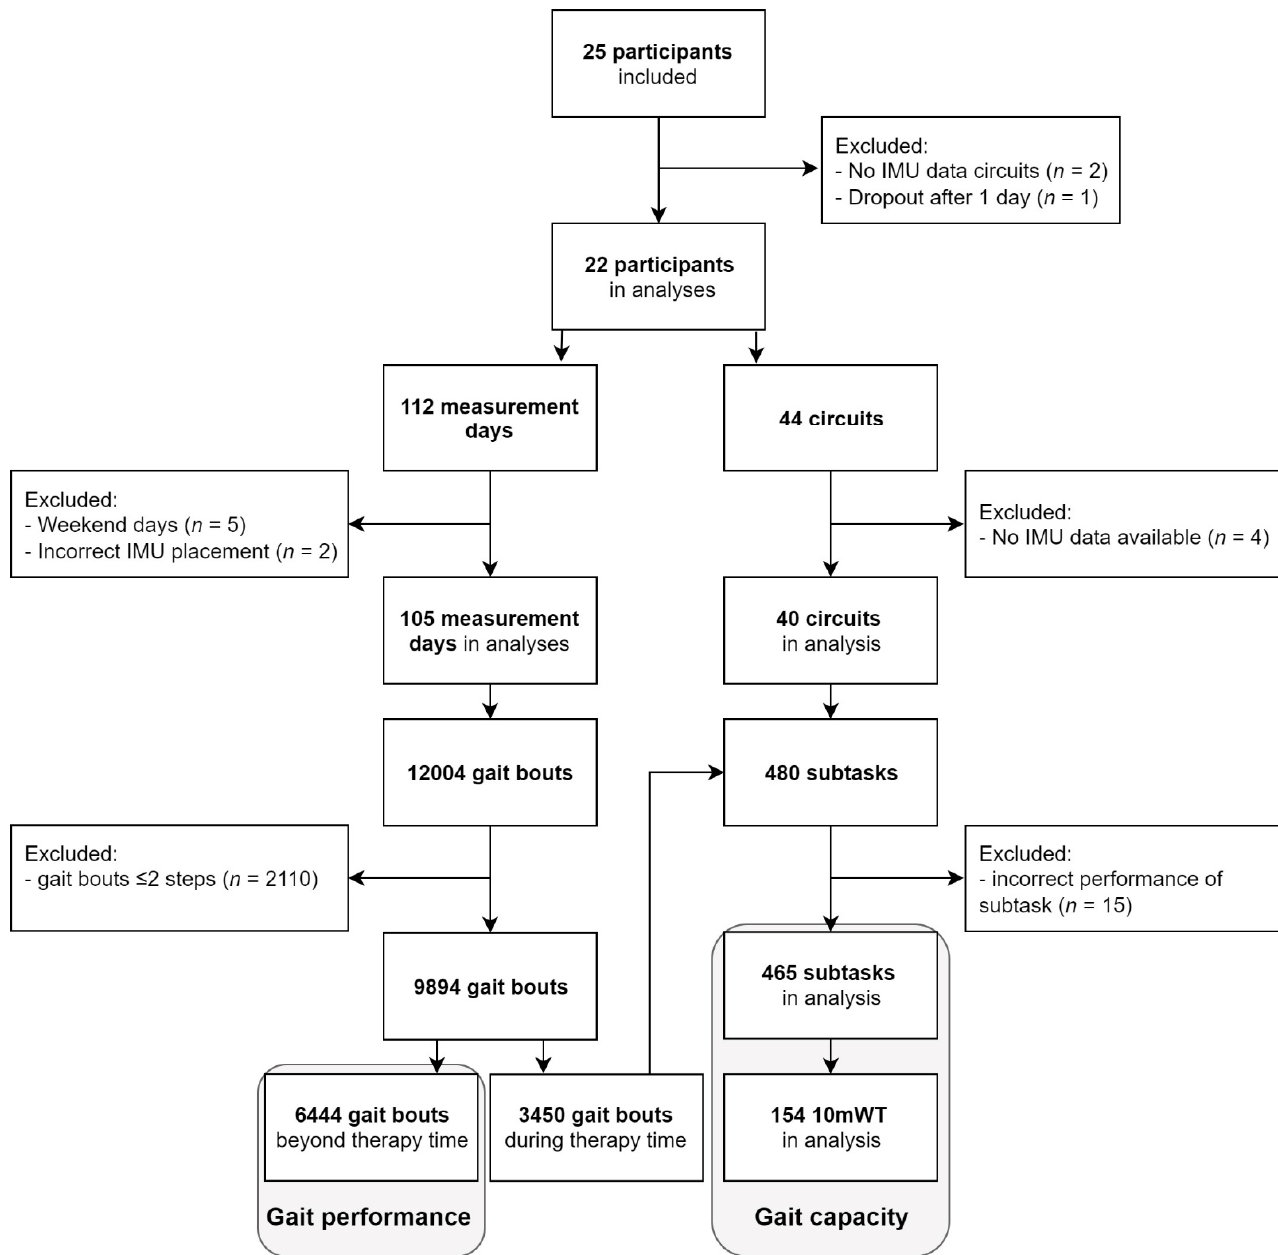
Figure 2. Flowchart of participants, measurement days, circuits, and gait bouts. Gait performance analysis was based on 6444 gait bouts performed beyond therapy time. Gait capacity analysis was based on 465 subtasks performed during circuits in therapy time, including 154 10mWTs.